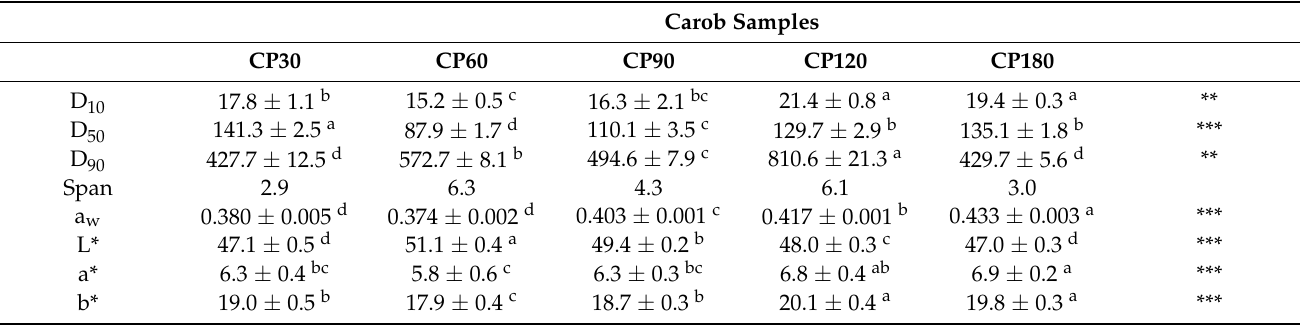
Table 1. Particle size ( µ m), water activity (a w ), and colour (CIEL*a*b*) of carob powder (CP) after vibratory